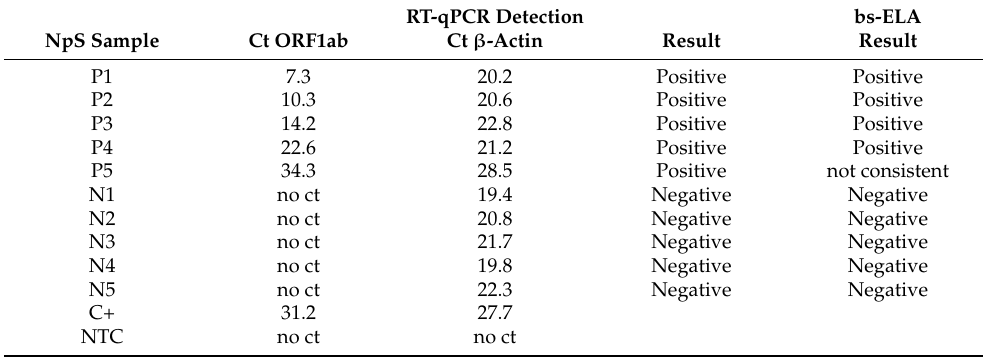
Table 2. Detection of SARS-CoV-2 on nasopharyngeal swabs by RT-qPCR and biotin-streptavidin- enzyme-linked